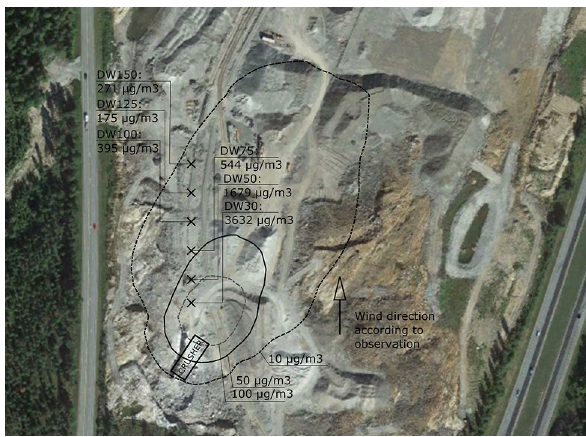
Fig. 3 Dust dispersion from the drilling during the measurement day 1. Modelled concentration contours of 50 µg PM models D1, D2 and D3, dashed black line, solid black line, and solid grey line, respectively. (D) denotes drill. Aerial photograph: Google Earth Pro